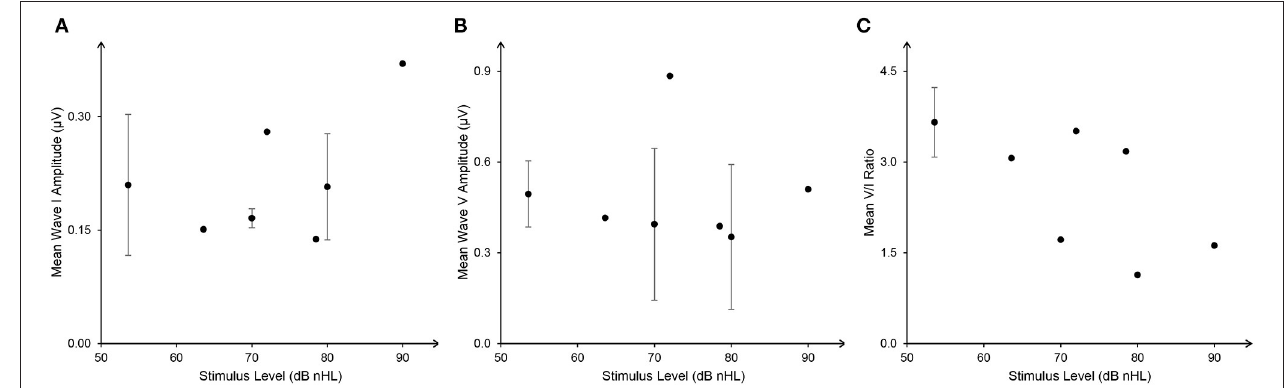
FIGURE 2 | The weighted relationship between stimulus level [dB normal hearing level (nHL)] and auditory brainstem response (ABR) wave I (A) , V amplitude (B) , and V/I ratio (C) (mean ± SD). ABR data with dB sound pressure level (SPL) and dB peak-equivalent sound pressure level (peSPL) were converted into dB nHL with the formula: 0-dB nHL = 36.4 peak SPL = 29.9 peSLP (in a condition of 100 µ s and